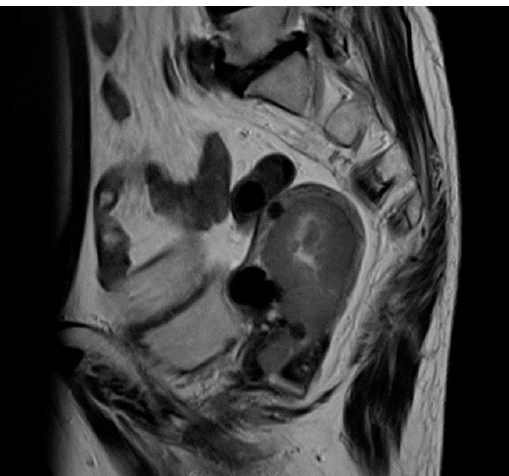
Figure 1. Magnetic resonance imaging of the pelvis. T2-weighted imaging revealed a thickened endometrial mass (50 × 73 × 43 mm).